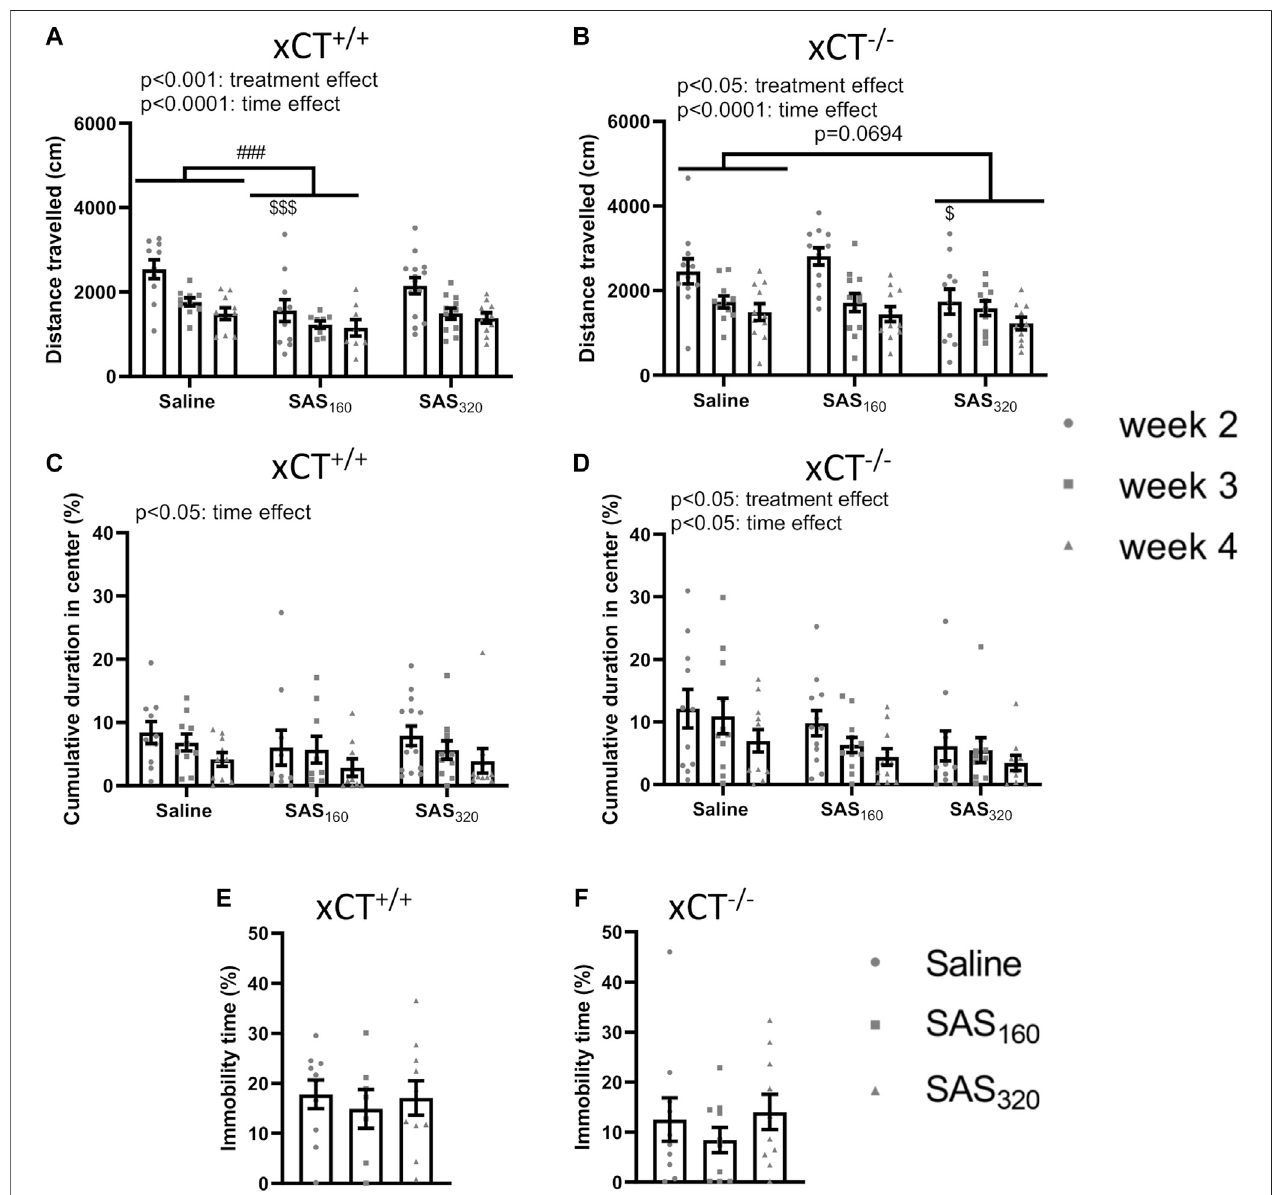
FIGURE3| Theeffectofchronicsulfasalazine(SAS)treatmentonlocomotorfunctionaswellasanxiety-anddepressive-likebehavior.Thetotaldistancetravelledin theopen fi eld(OF)testwasusedtomeasure locomotor functionofxCT +/+ ( n (cid:2) 10 – 14mice/groupatthestartoftheexperiment, n (cid:2) 8 – 11mice/groupafterfour weeksof treatment) (A) and xCT − / − mice ( n (cid:2) 11 – 12 mice/group at the start of the experiment, n (cid:2) 10 – 11 mice/group after four weeks of treatment) (B) , starting from the second week of treatment. The cumulative duration spent in the center of the OF arena was plotted to study anxiety-like behavior (C,D) . The immobility-time in the mouse tail suspension test (MTS) performed after four weeks of treatment was assessed as a parameter for depressive-like behavior ( n (cid:2) 7 – 10 xCT +/+ mice/group (E) ; n (cid:2) 10 xCT − / − mice/group (F) ). Data are presented as mean ± SEM and analyzed using a two-way ANOVA followed by Sidak ’ s multiple comparisons for each dose of SAS compared to saline for the OF: ## p < 0.01, ### p < 0.001: for treatment effect over all timepoints; $ p < 0.05, $$$ p < 0.001: for treatment effect at one speci fi c timepoint. MTS data were analyzed using a Kruskal-Wallis test.